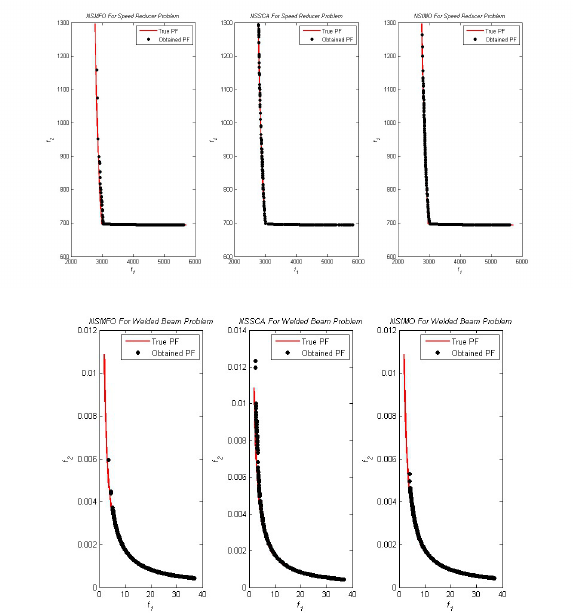
Fig. 9. Best Pareto optimal front of Real World Engineering Problems obtained by the NSMFO, NSSCA, and